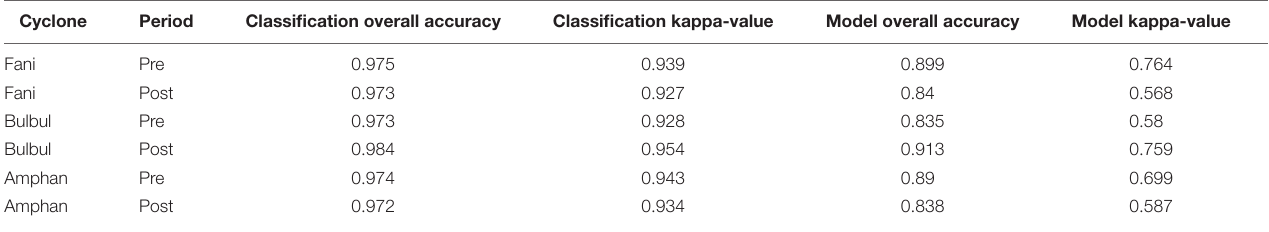
TABLE 3 | Consumers accuracy, producers accuracy, and kappa-values of classification (training sample) and model (test sample).